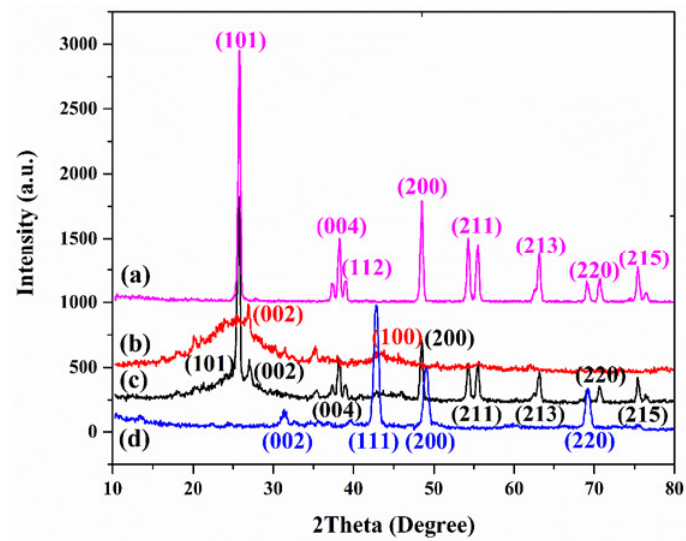
Fig. 2. XRD patterns of (a) graphene oxide, (b) TiO